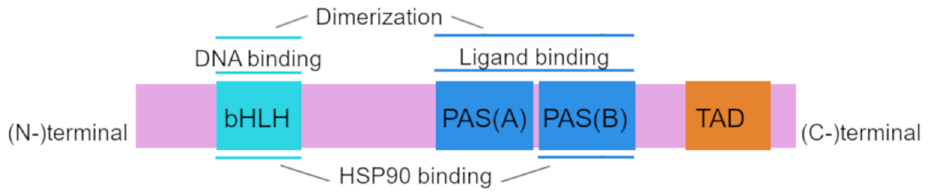
Figure 1. Structure of aryl hydrocarbon receptor (AhR). The basic helix–loop–helix (bHLH) motif, common among various transcription factors, is located at the N terminus of the AhR protein and is involved in DNA binding and protein–protein interactions. Per–ARNT–Sim (PAS) domains (PAS-A and PAS-B) participate in binding to ligands and to HSP90 proteins and in dimerization with partner proteins. The transactivation domain (TAD) is located at the C terminus of the AhR protein.